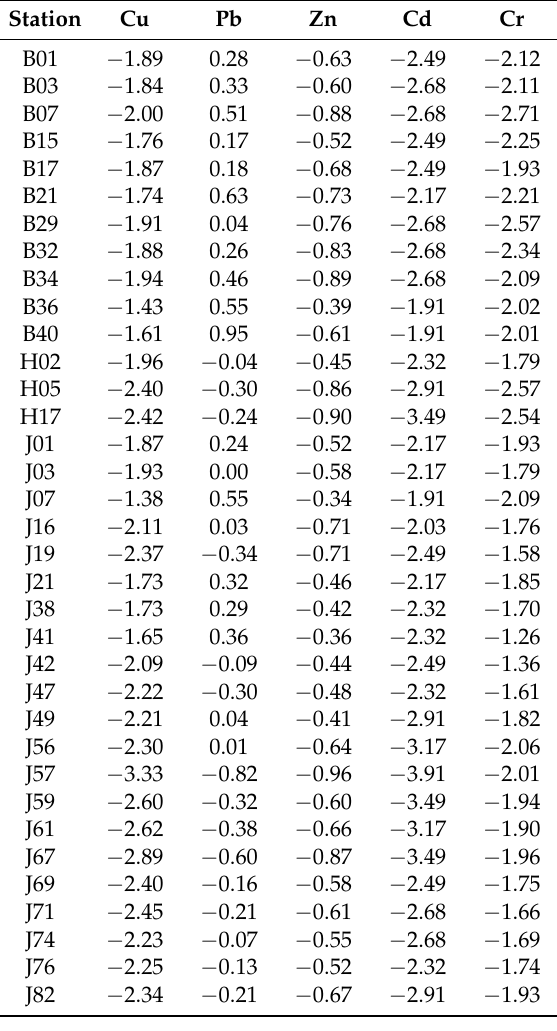
Table 3. Geoaccumulation index (I geo ) values of heavy metals in the eastern Beibu